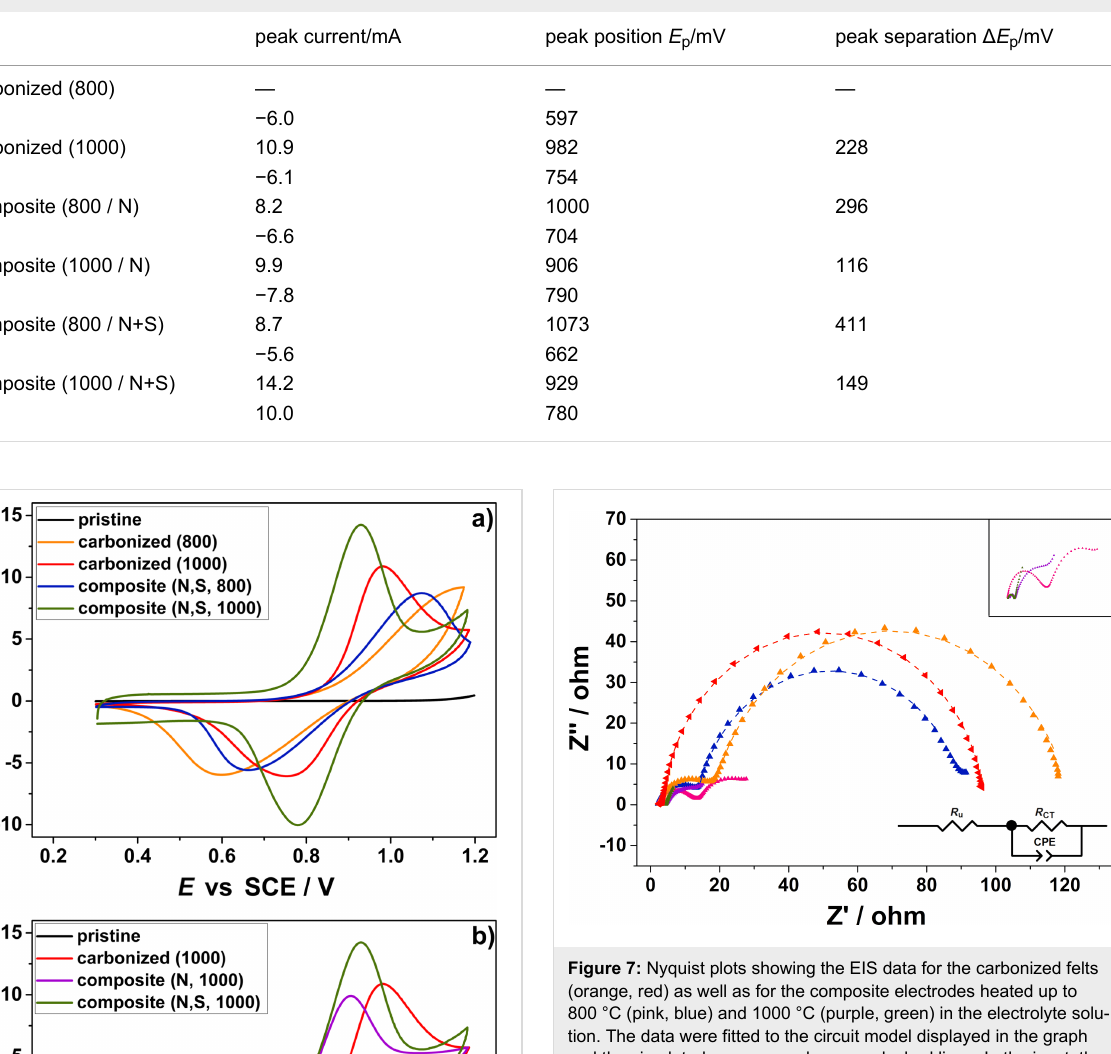
Table 3: Electrochemical data of the VO 2+ /VO 2+ redox couple obtained from cyclic voltammograms.